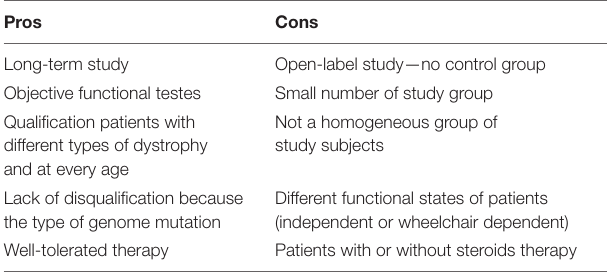
TablE 5 | Cons and pros granulocyte colony-stimulating factor therapy in patients with Duchenne muscular dystrophy. Pros